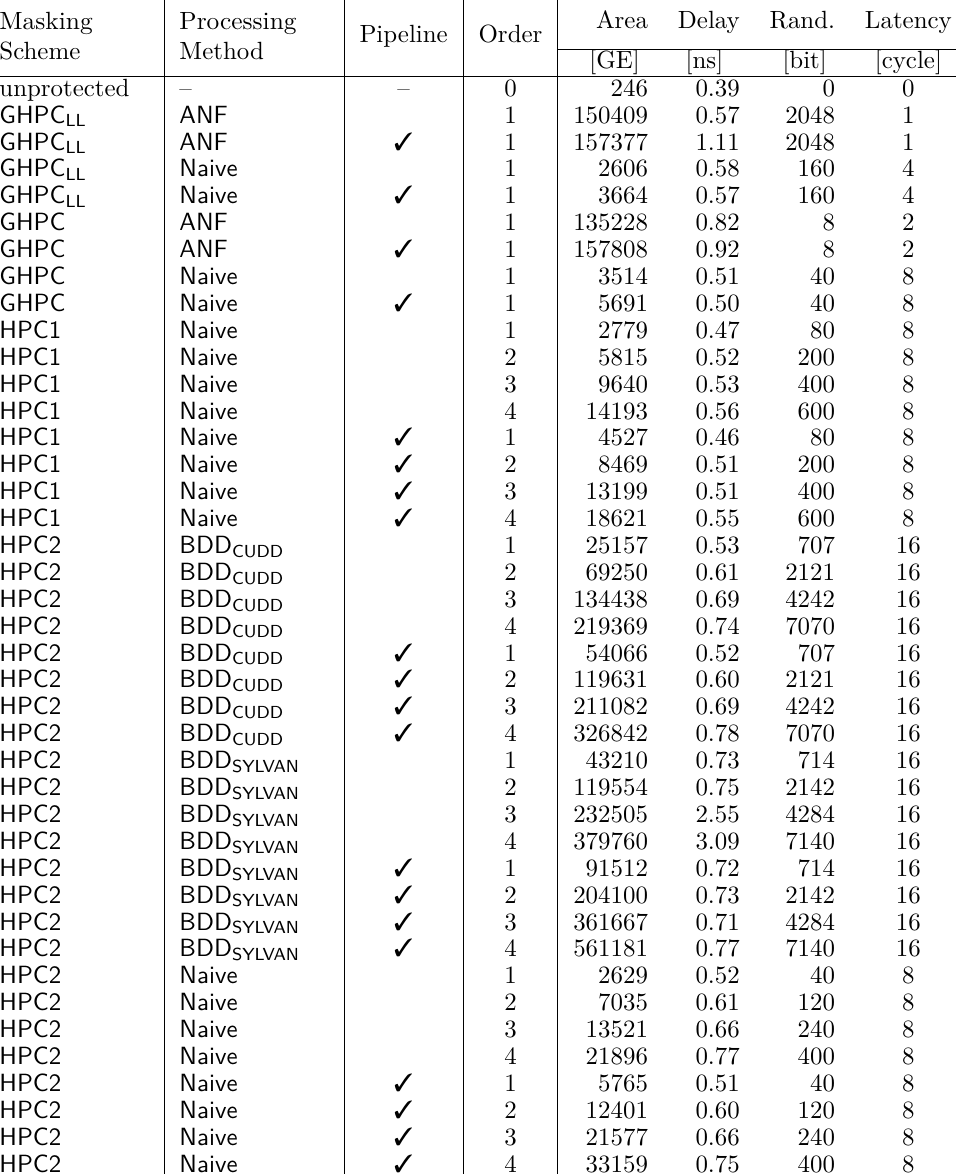
Table 6: Synthesis results, AES S-box Canright